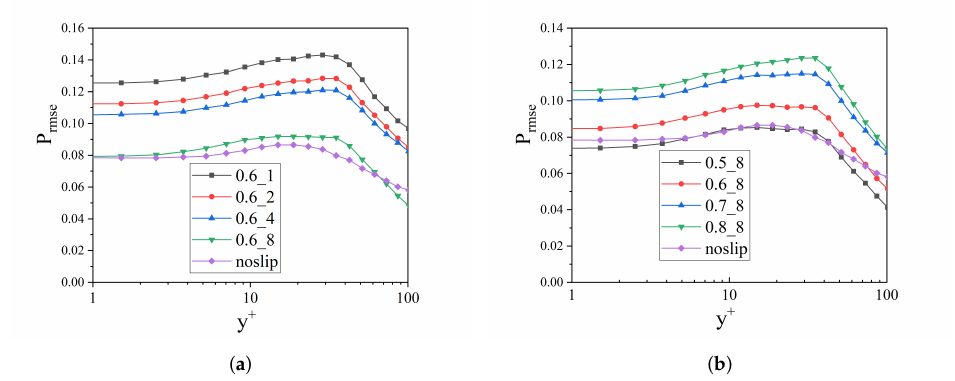
Figure 9. Comparison of pressure RMSE at the bottom wall of channel(superhydrophobic